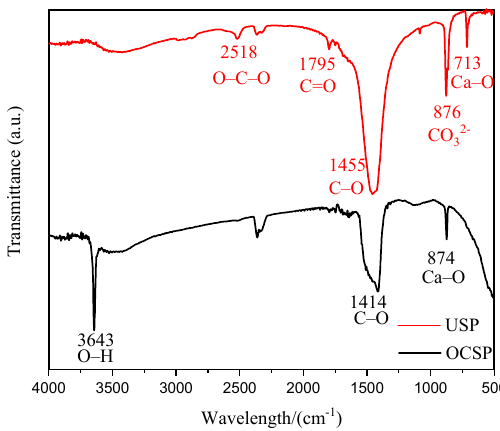
Figure 5. FT-IR analysis of USP and OCSP.